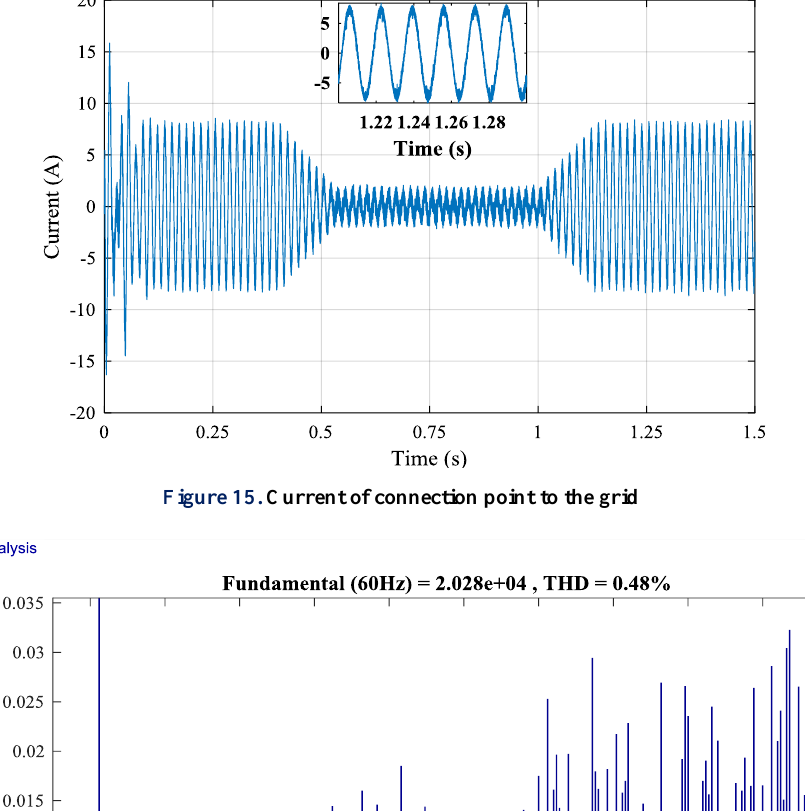
Figure 15. Current of connection point to the grid